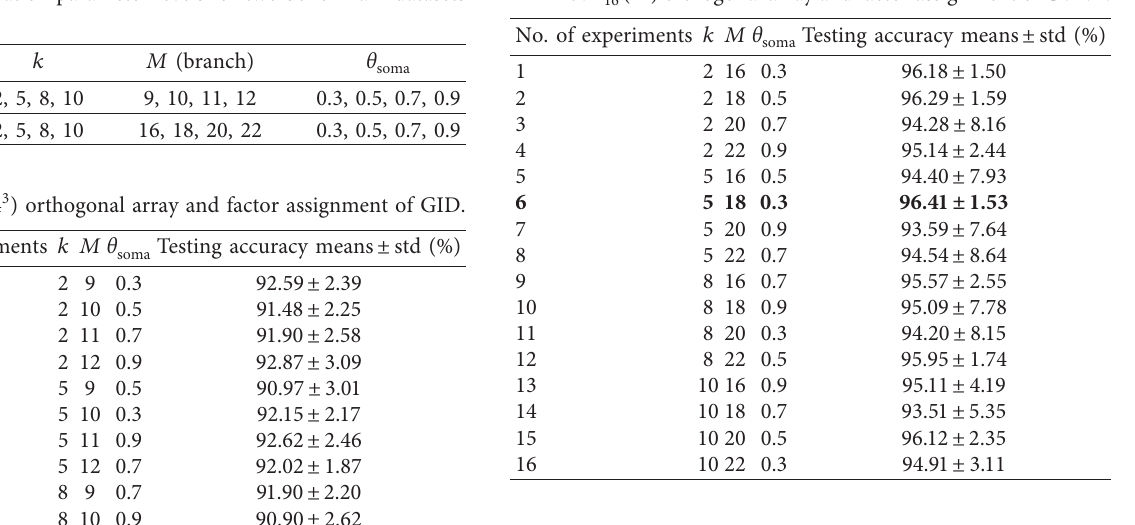
Table 7: L ( 4 3 ) orthogonal array and factor assignment of CVRD. 16